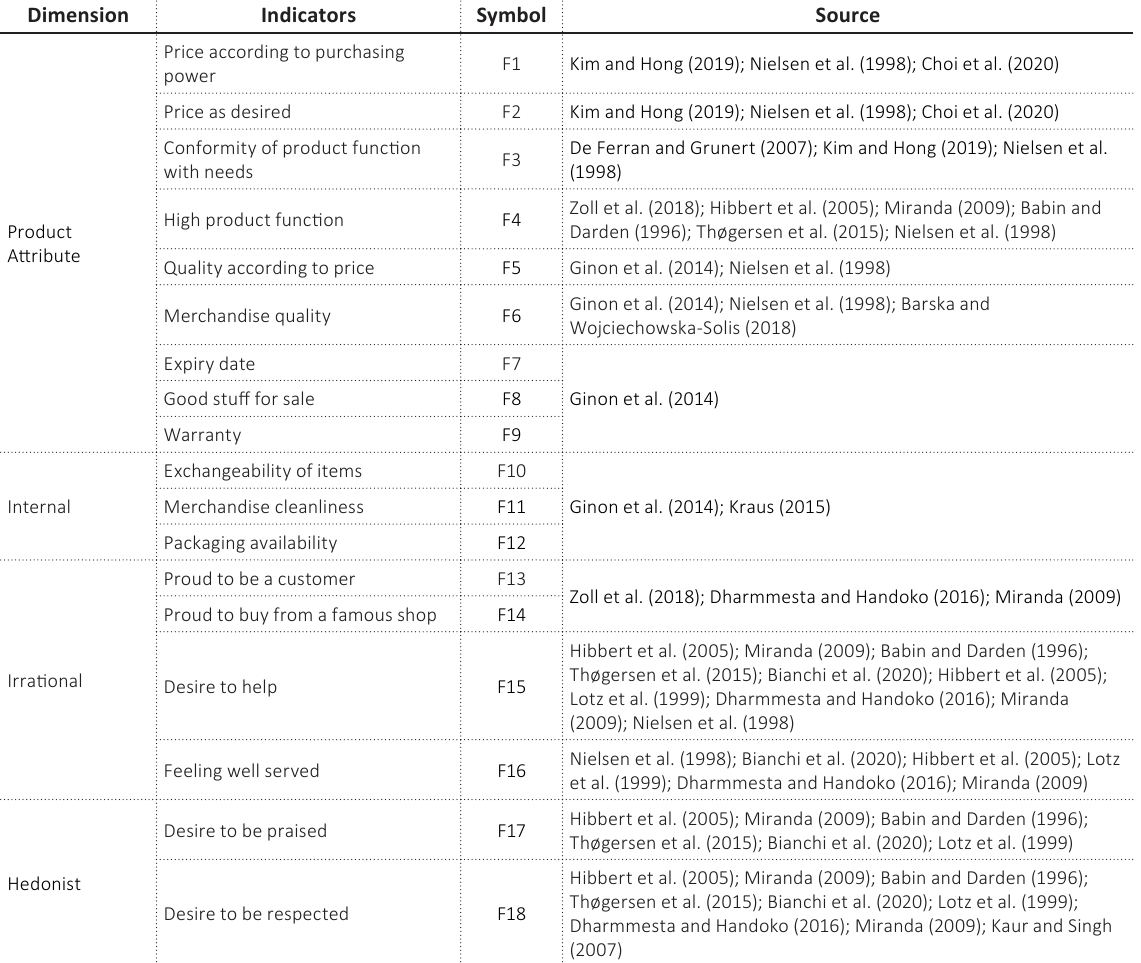
Table 1. Measuring components and